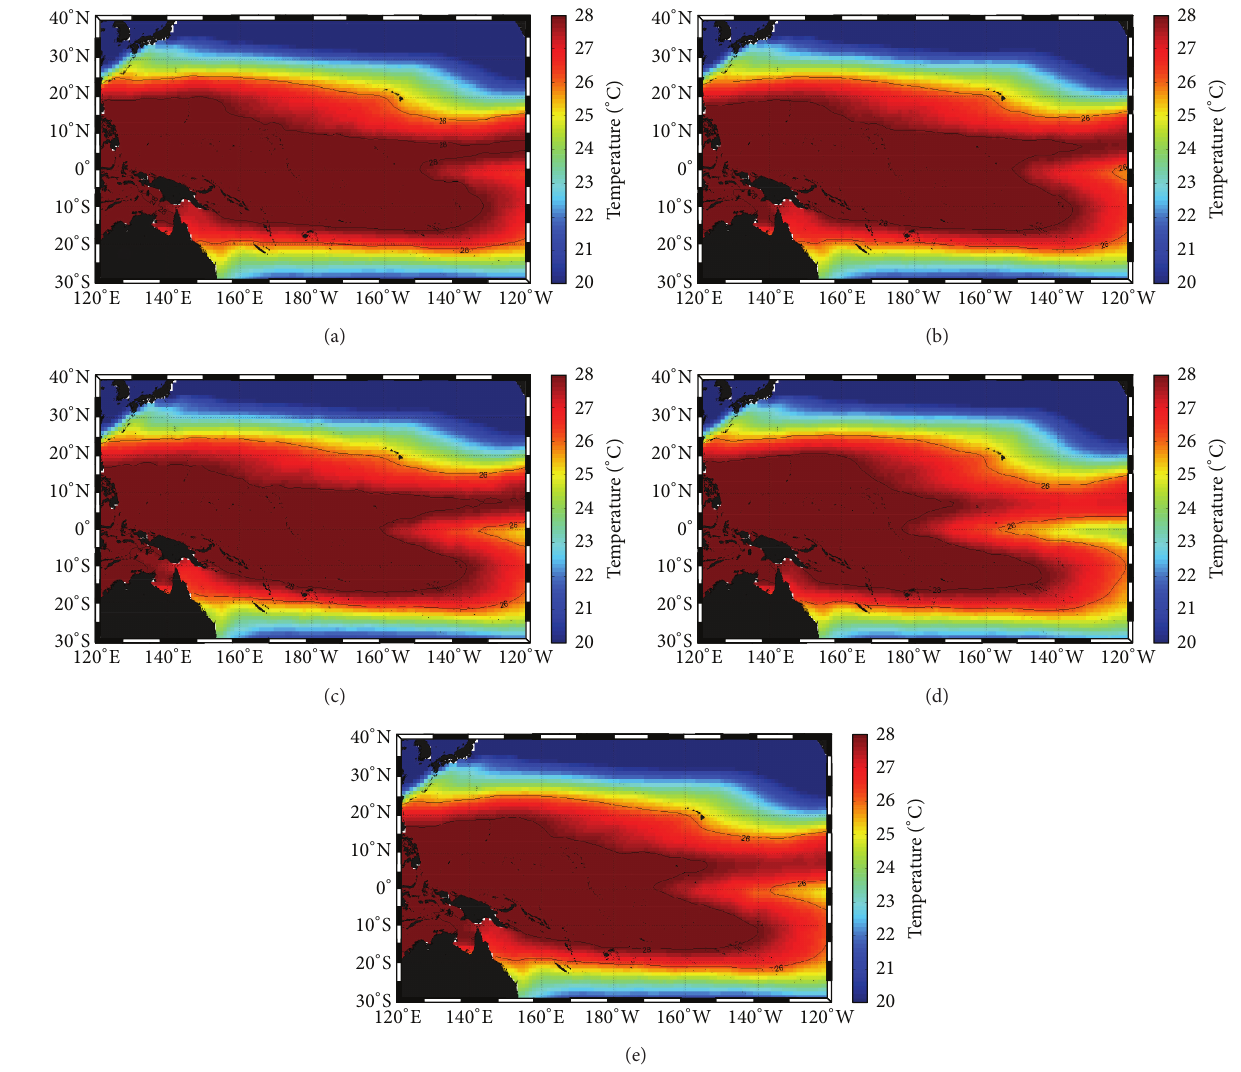
Figure 5: The distribution of average SST in (a) El Ni˜no, (b) El Ni˜no Modoki I, (c) El Ni˜no Modoki II, (d) La Ni˜na, and (e) normal years.